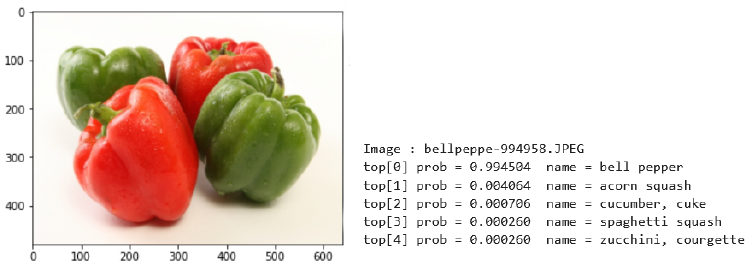
Figure 3. Object classification